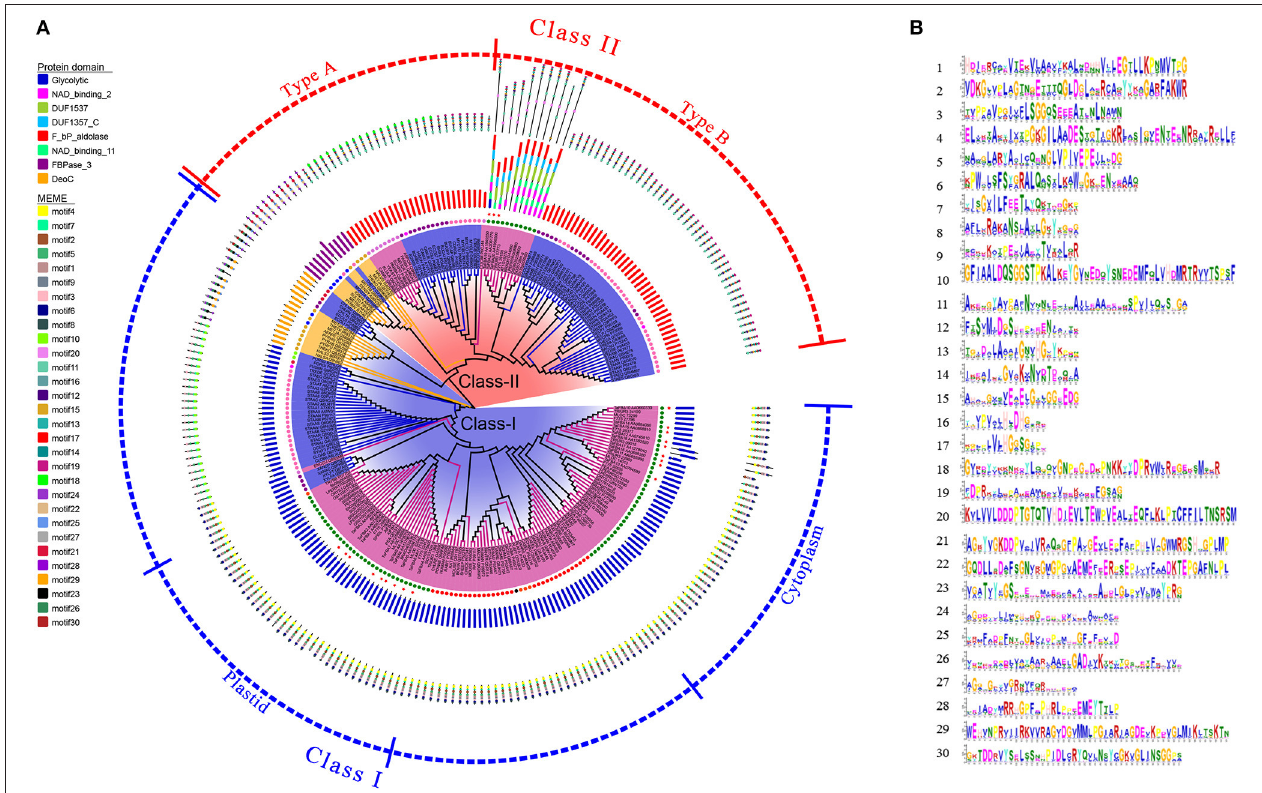
FIGURE 3 | Phylogenetic and structure analysis of the FBA proteins. (A) The phylogenetic tree of FBA proteins constructed with Clustal Omega. Class I and class II FBA subfamilies are distinguished by blue and red colours respectively. with the full-length amino acid sequences of the 245 FBA proteins. 19 archaea FBAs are indicated by orange branches. 97 bacteria FBAs are indicated by blue branches. 129 eukaryota FBAs are indicated by purple branches. Red circle represents bilaterian. Green circle represents viridiplantae. Crimson circle represents chlamydia. Black circle represents Dictyostelium discoideum . Gold circle represents Euryarchaeota . Orchid circle represents fungi. Orange circle represents Plasmodium . Chartreuse circle represents Porphyromonas gingivalis . DarkMagenta circle represents Proteobacteria. Magenta circle represents Spirochaetales. Blue circle represents TACK group. Pink circle represents terrabacteria group. 21 TaFBAs were shown by little red circle. The annulus next to the tree represents the protein domains of FBAs and the outside annulus represents the MEME motifs. (B) Motif LOGOs of FBA proteins generated by